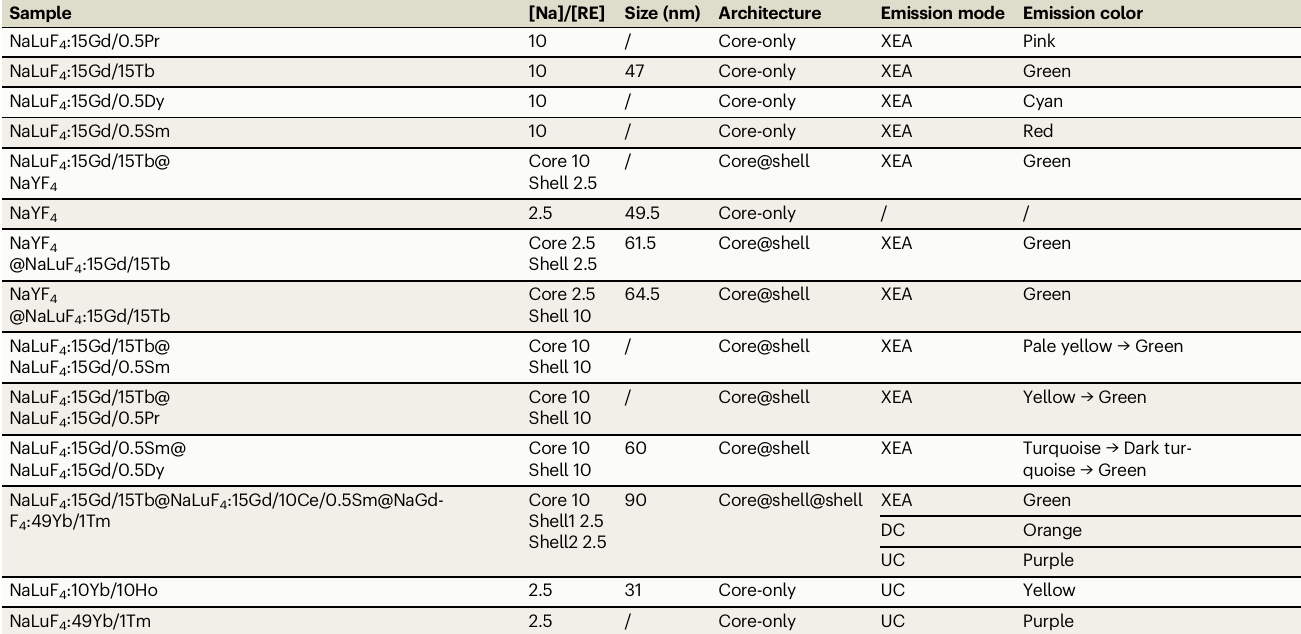
Table 2 | Comparison of different samples studied in this work